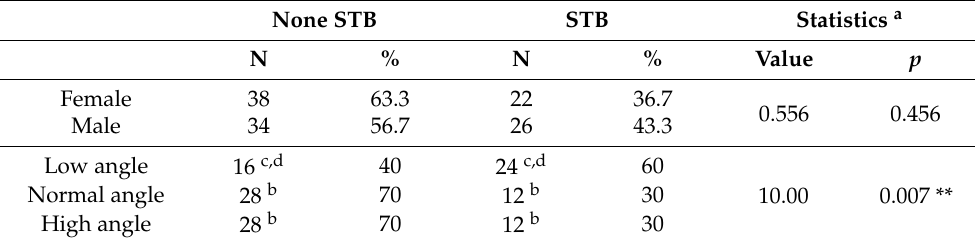
Table 9. Difference in STB in genders and three groups. None STB